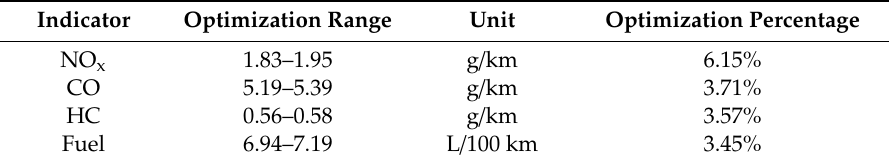
Table 5. Indicator optimization range and percentage.